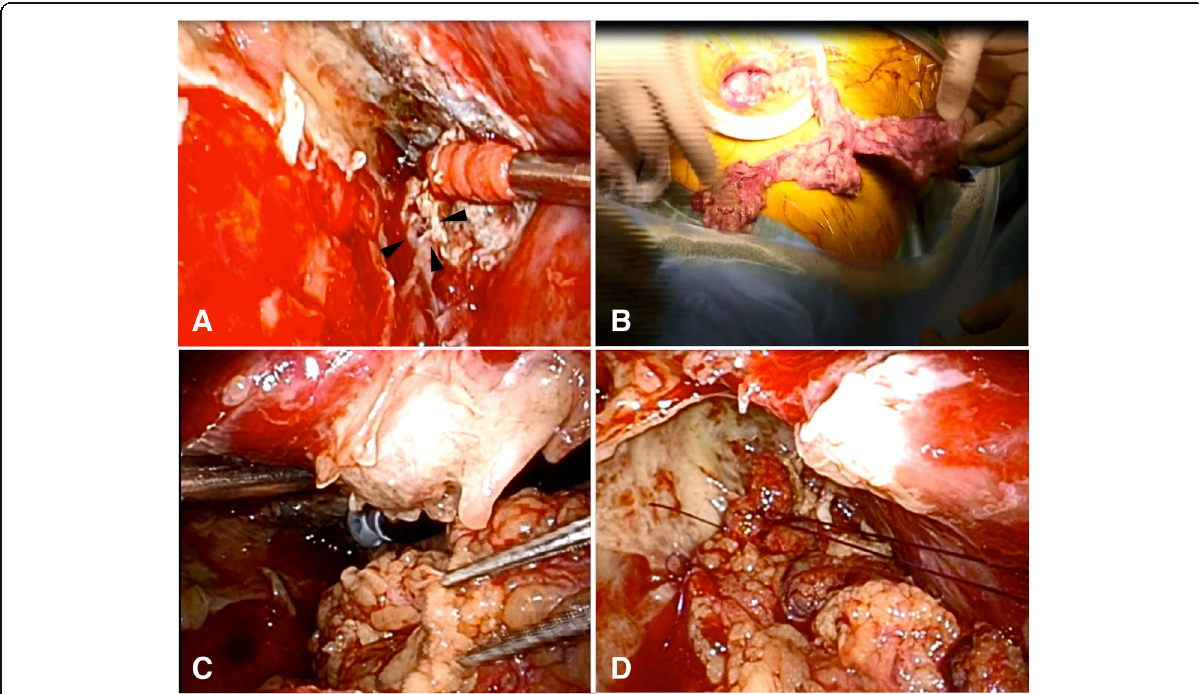
Fig. 2 Surgical findings on re-operation. a The arrows indicate the bronchial fistula. b The omental flap during laparotomy. c, d The omental flap has been harvested and fixed in the thoracic cavity